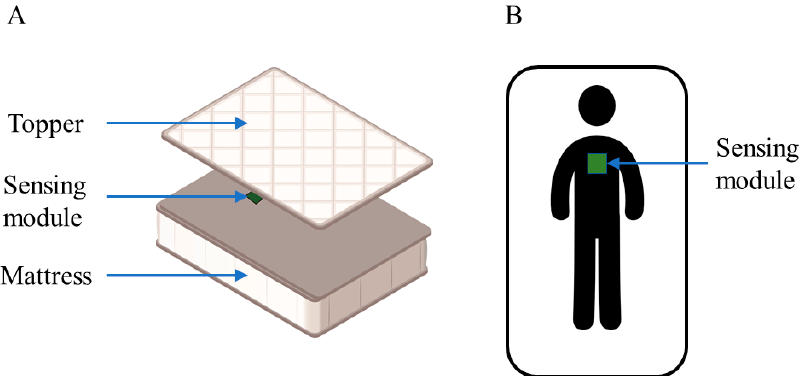
Figure 4. Location of the sensing module in the bed: perspective view ( A ) and top view ( B ).